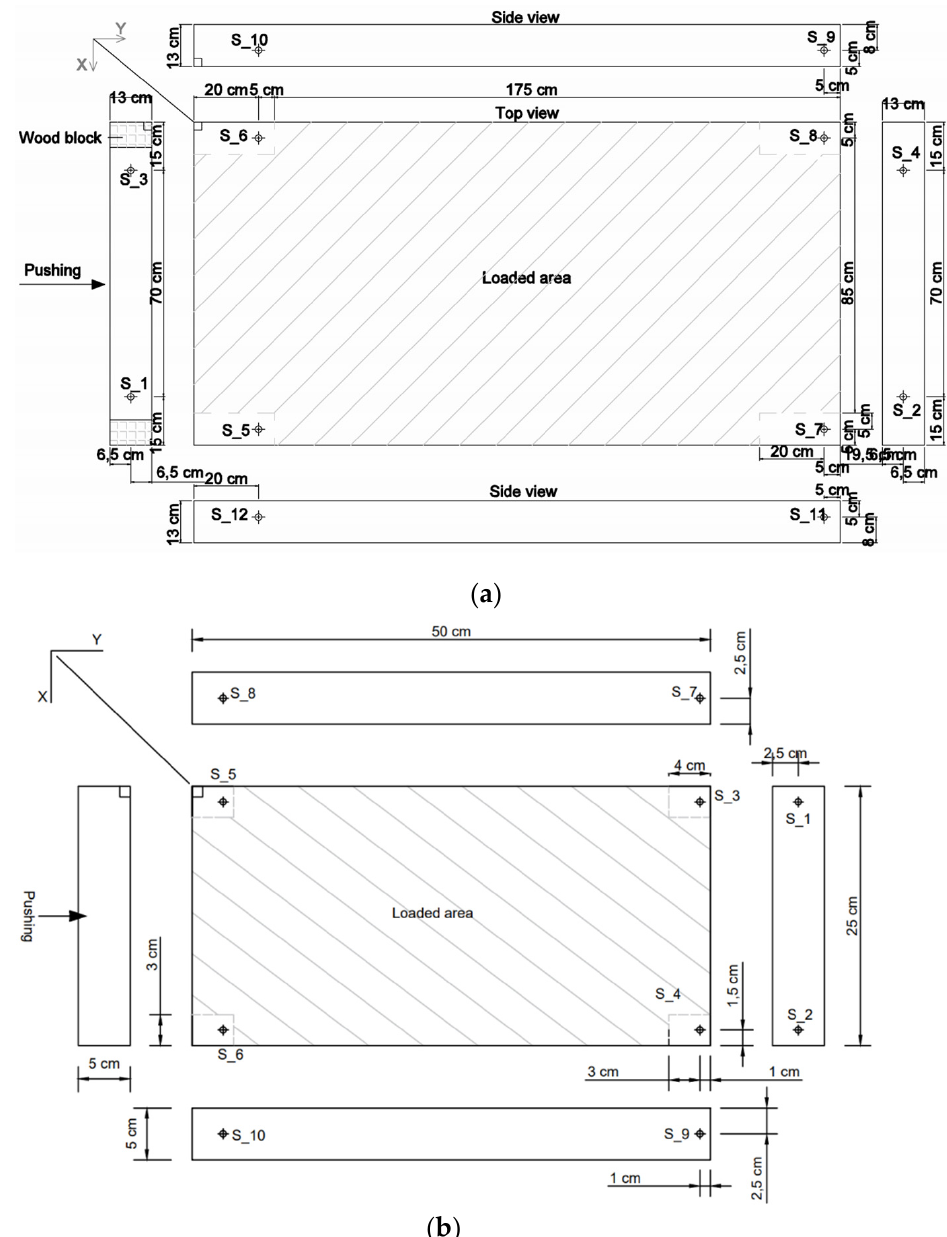
Figure 5. Layout of the locations of the displacement sensors: ( a ) large, and ( b ) medium. The positions of the linear variable differential transformers (LVDTs) are shown by the symbol S.